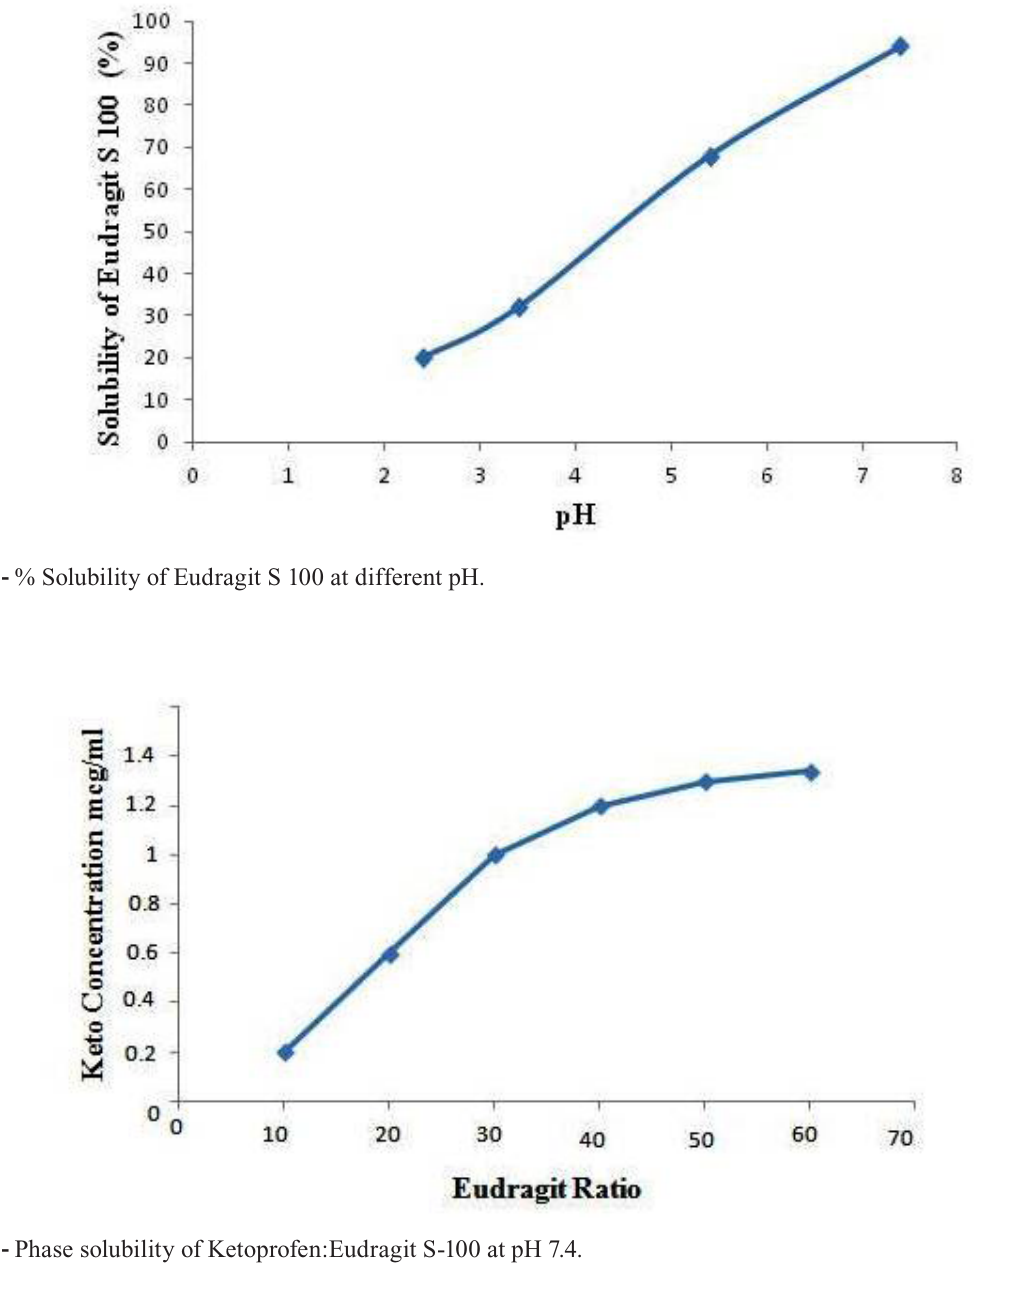
ATR-FTIR spectroscopy (C-H deformation), 1695.602 cm -1 (C=O stretching),